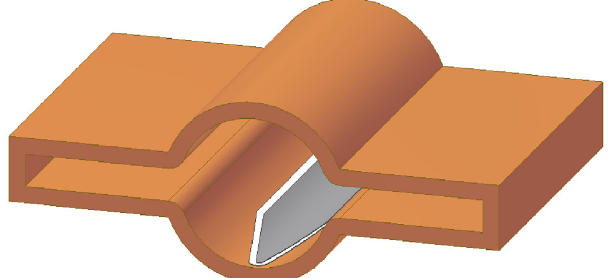
6. Wiggler magnet vacuum chamber showing the clearing electrode.